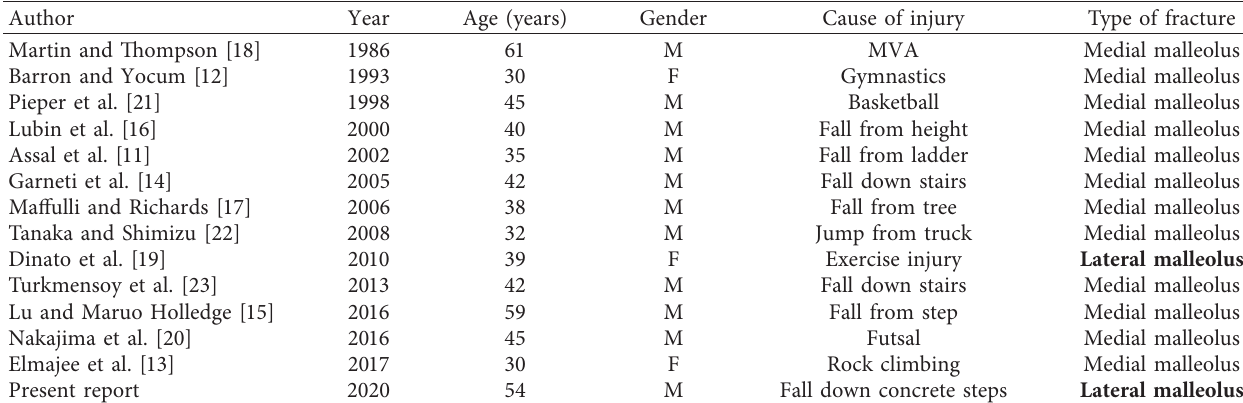
Table 1: Previous case reports in English language